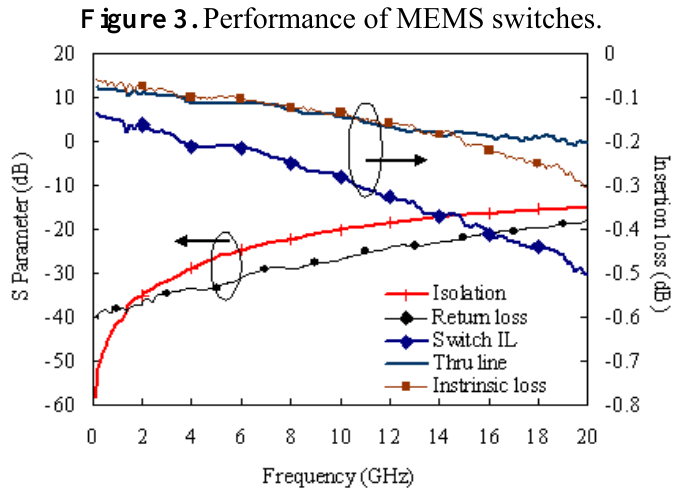
Figure 3. Performance of MEMS